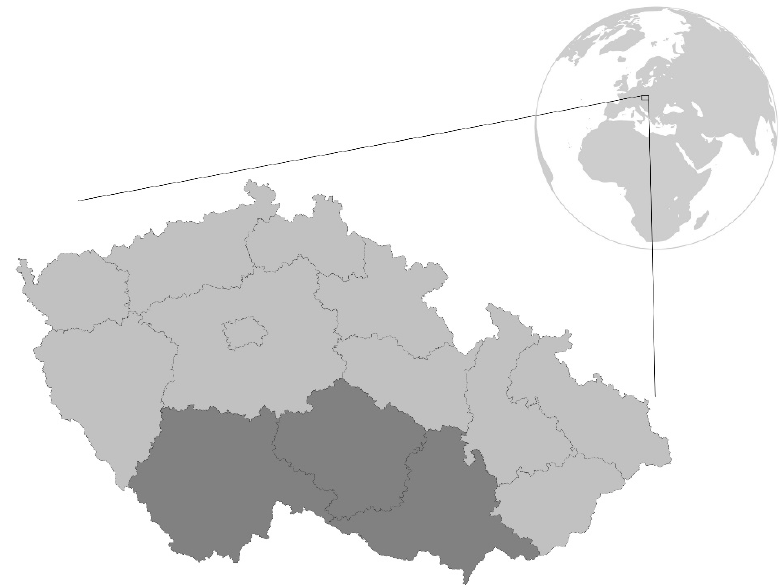
Figure 4. The area under study.